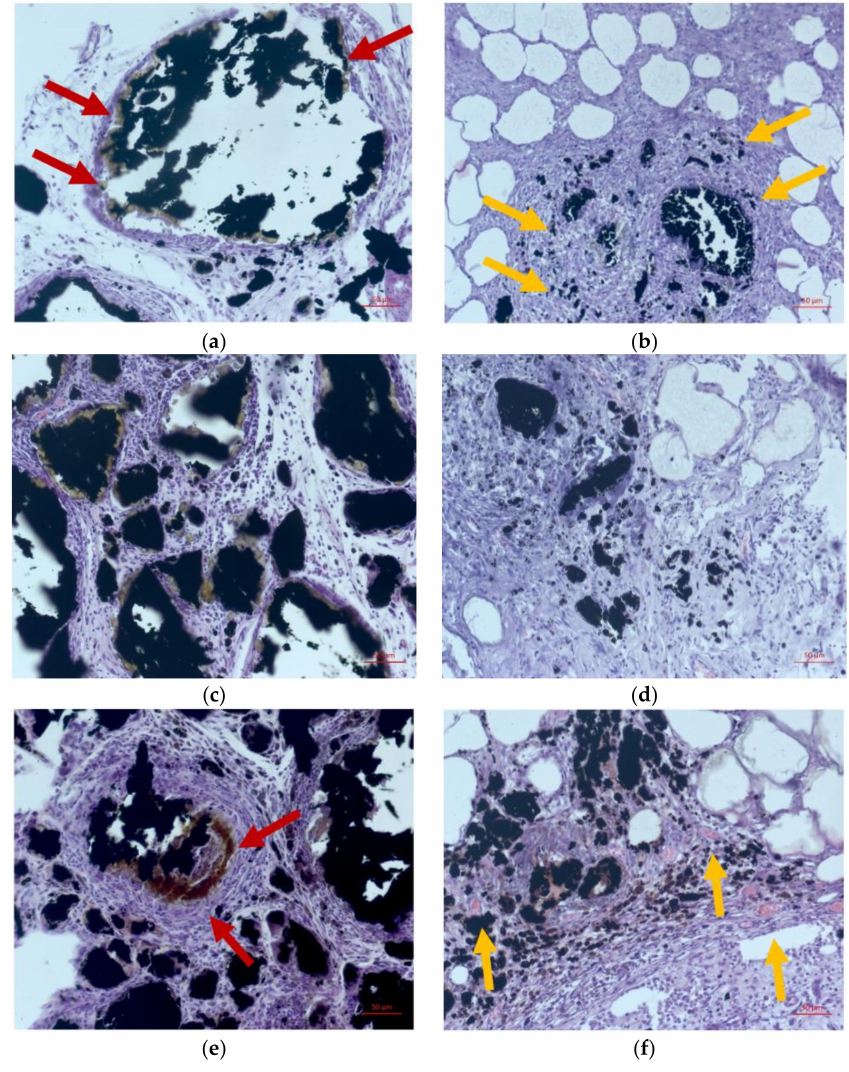
Figure 1. Morphological studies of CoCr tubes with PLA and Fe@C NP coatings after 7, 14, and 21 days of implantation. In samples with modified nanoparticles (group 1) there was a moderately pronounced edema and minimal infiltration by lymphocytes and macrophages around the agglom- erates of the nanoparticles. Moreover, it was observed that «fringing» phenomenon manifested by the changes of the color and optical density in nanoparticles peripheral zone. Scale bar is 50 µ m. ( a , c , e ) Modified Fe@C NPs (Group 1). ( b , d , f ) Unmodified Fe@C NPs (Group 2). Time: 7 days ( a , b ), 12 days ( c , d ), and 21 days ( e , f ). Red arrows indicate the presence of a fringing effect, and yellow arrows indicate its absence. Table 1. Quantitative estimation of metachromatic staining (total area µ m 2 ) in the structure of the subcutaneous fat of laboratory animals (n = 5, five animals for every group), depending on the time of their contact with chemically modified and non-modified Fe@C